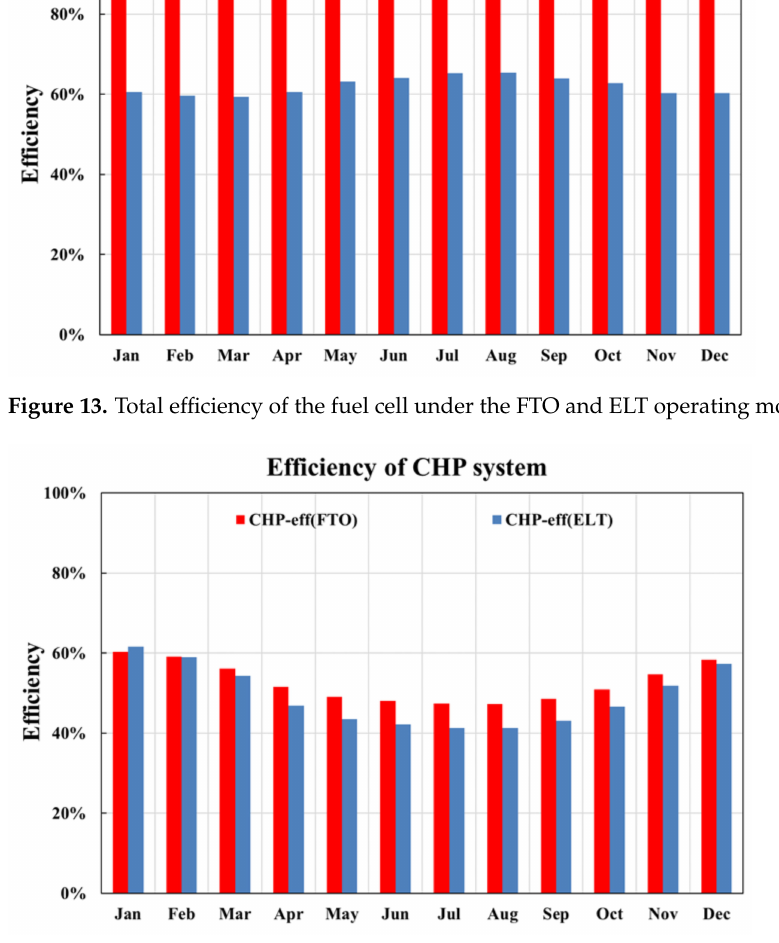
Figure 14. Efficiency of the FC-CHP system under the FTO and ELT operating